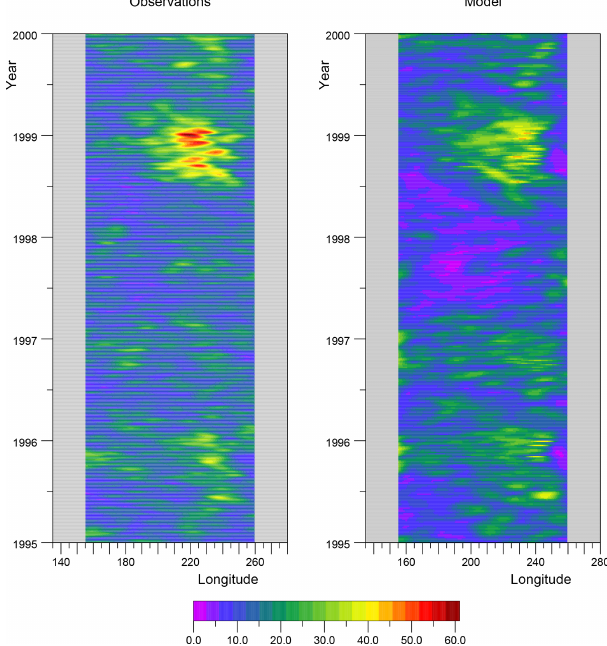
Figure 6. Rms variance of the northward component of ocean sur- face geostrophic velocity at 6 ◦ N. The values were calculated from the satellite altimeter and model sea surface height fields using Eqs. (1) and (2). Units are centimetres per second (cms − 1